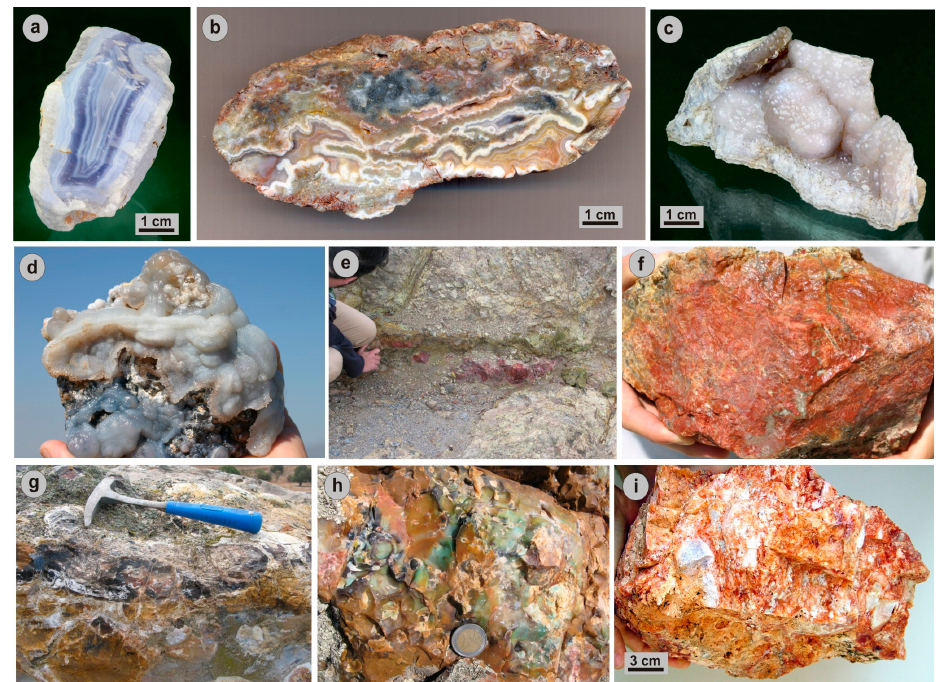
Figure 10. Field and hand specimens photographs demonstrating gem microcrystalline and amorphous silica varieties from Greece: ( a ) blue agate from Aetochori, Evros; ( b ) agate from Lefkimi, Evros; ( c ) chalcedony from Kornofolia, Evros; ( d ) blue chalcedony from Petsofas, Lesvos Island; ( e ) red jasper layer within smectite-altered pyroclastics, Sapes, Rhodopi; ( f ) red jasper from Sapes, Rhodopi; ( g , h ) brown and green opalized wood from Moudros, Limnos Island; ( i ) red opal from Agioi Theodoroi, Milos Island. Photographs 10 a,c courtesy Berthold